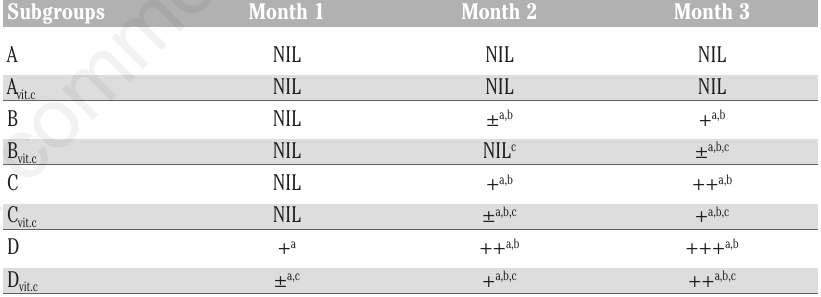
Table 3. Mean urine glucose qualitative detection in treated